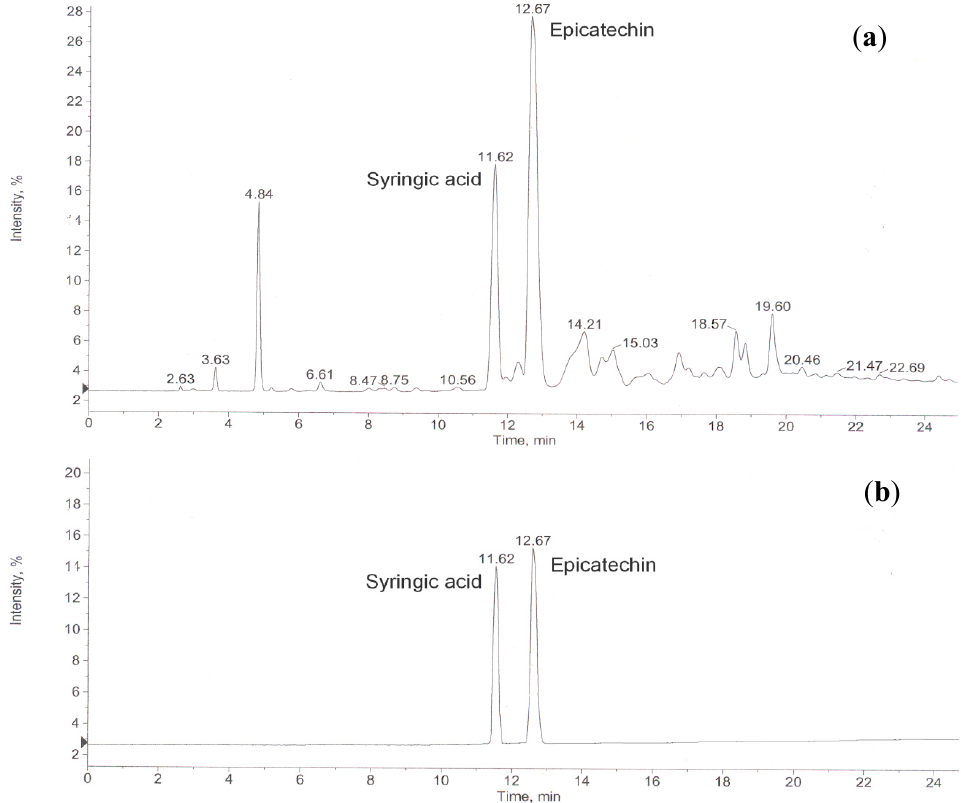
Figure 1. Typical HPLC-UV chromatograms of ( a ) 70% ethanol extracts of areca seeds and ( b ) mixed standard solution of syringic acid and